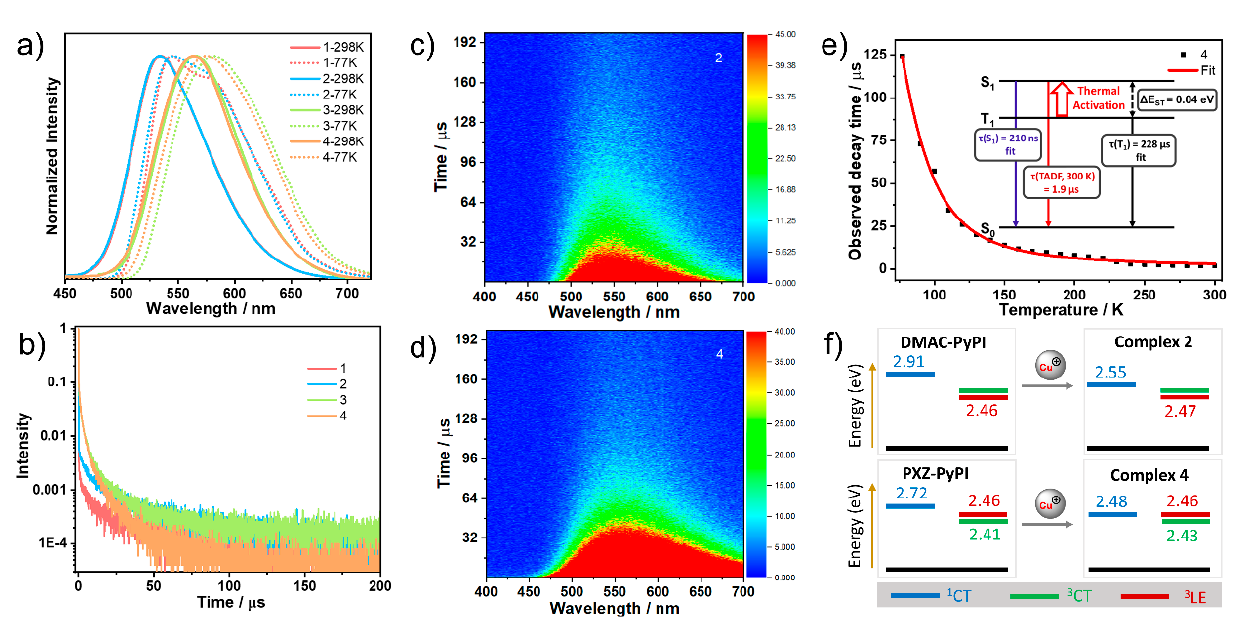
(PL) spectra at 298 K and 77 K; ( b ) transient PL characteristics for 1 – 4 ; time-resolve PL spectra of ( c ) 2 and ( d ) 4 ; ( e ) analysis of the variable